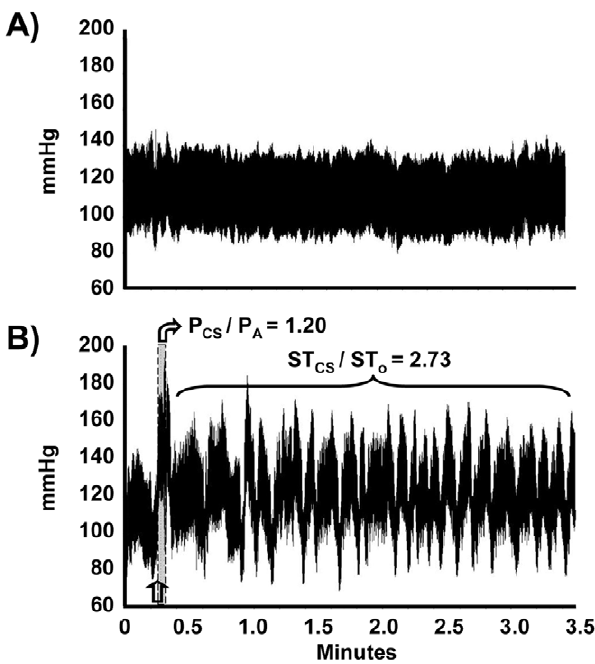
Figure 5. The CS-evoked BP alterations after the completion of a training session with 7 paired CS-US trials. Under our standard protocol, an animal in the training cabinet remained quiescent after finishing the training session (A). As a comparison, if a similarly trained animal encountered an extra CS (B), it showed high values of P CS /P A (3-s average) and ST CS /ST 0 (180-s average).